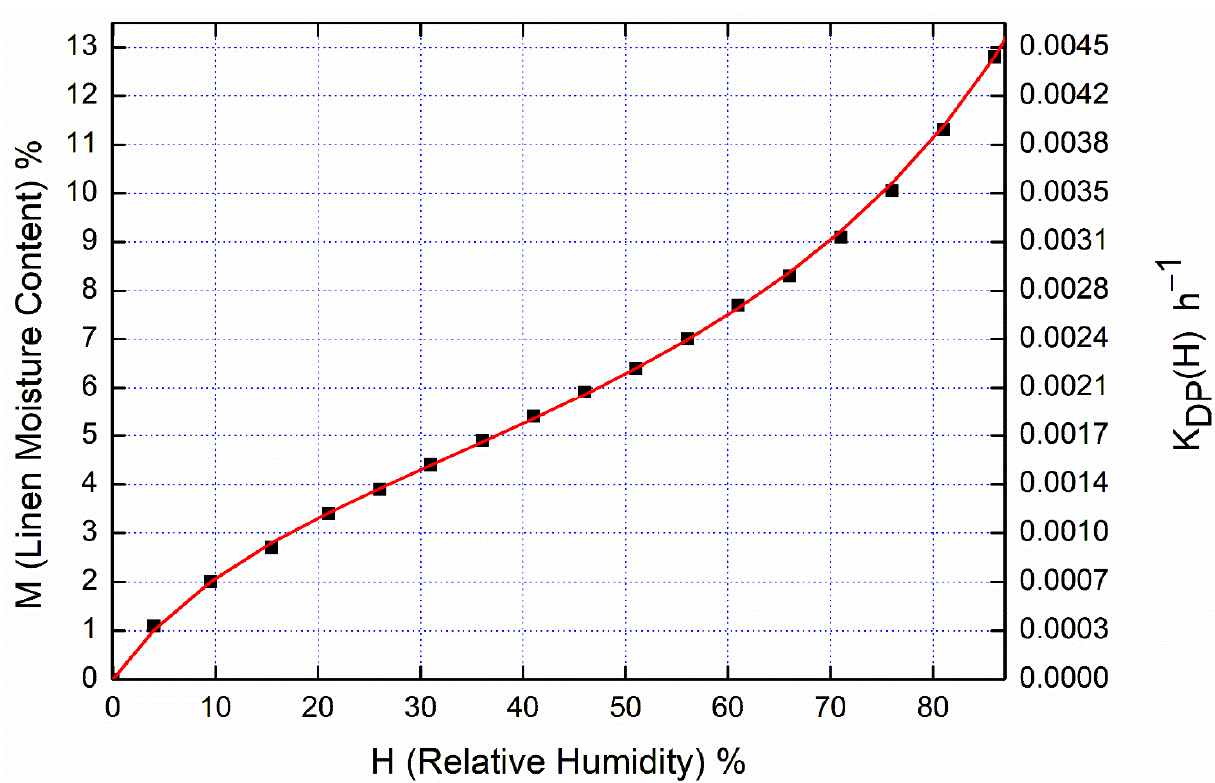
Figure 2. Left scale: linen moisture sorption isotherm data M (black points) [34], fitted with a GAB model [35]. Right scale: k DP values obtained by imposing that k DP = 0.0022 h − 1 for H = 50% [32].